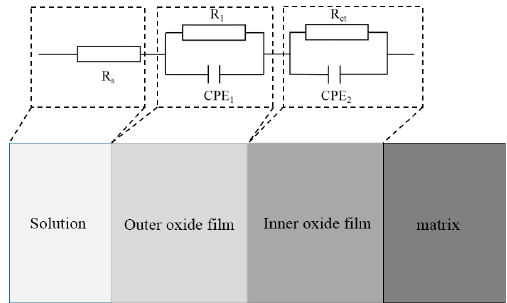
Figure 6. Equivalent circuit for an EIS fitting.